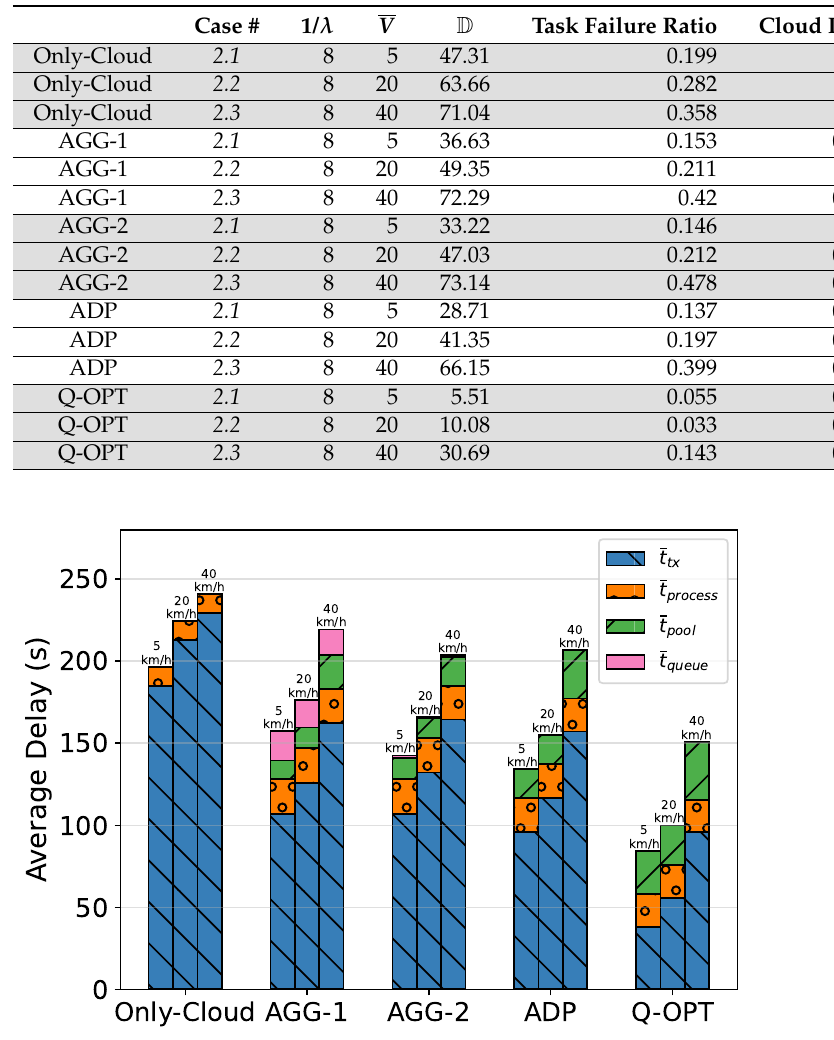
Figure 11. Impact of average vehicle speed on task delay